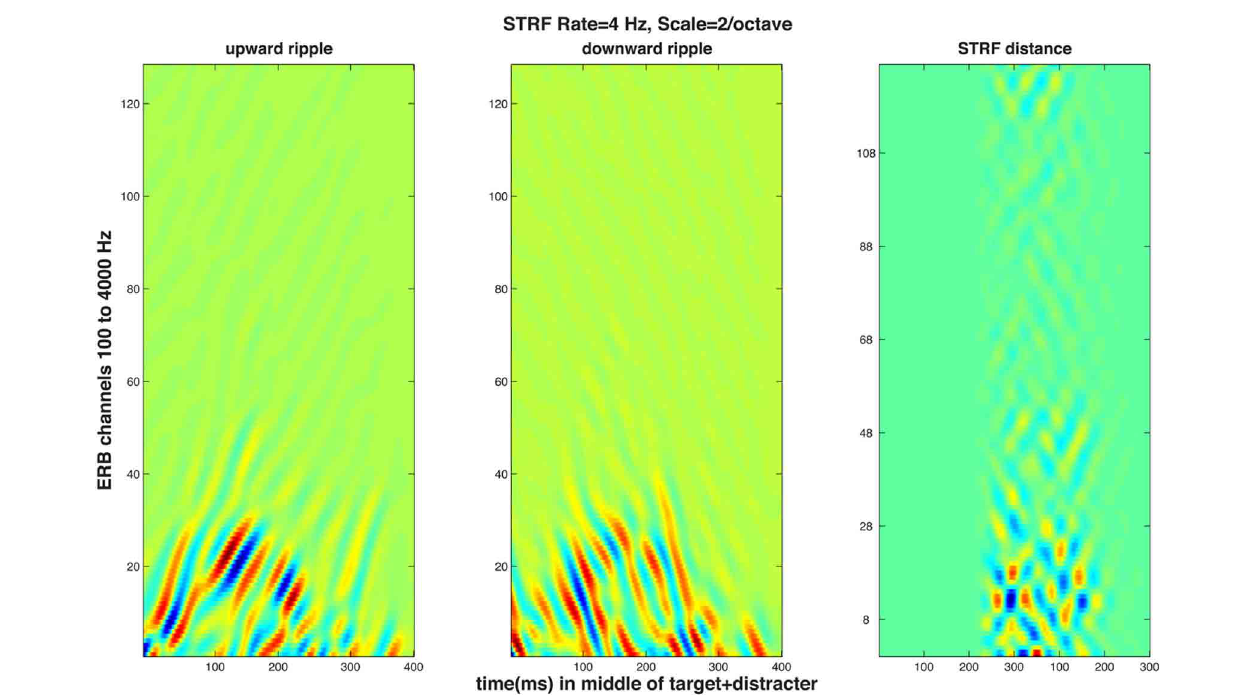
FIGURE 4 | STRF magnitude responses to a target-plus-distracter stimulus. The graphs represent simulated cortical response patterns of 128 channels tuned to frequencies aligned on an equivalent rectangular bandwidth (ERB) scale, as a function of time over the 600-ms middle portion of the stimulus containing 600-ms of the distracter and 400ms of the target (see Figure 1 ) starting 100ms after the portion of the distracter shown. All panels refer to STRF activity of regions tuned to 4-Hz temporal modulation